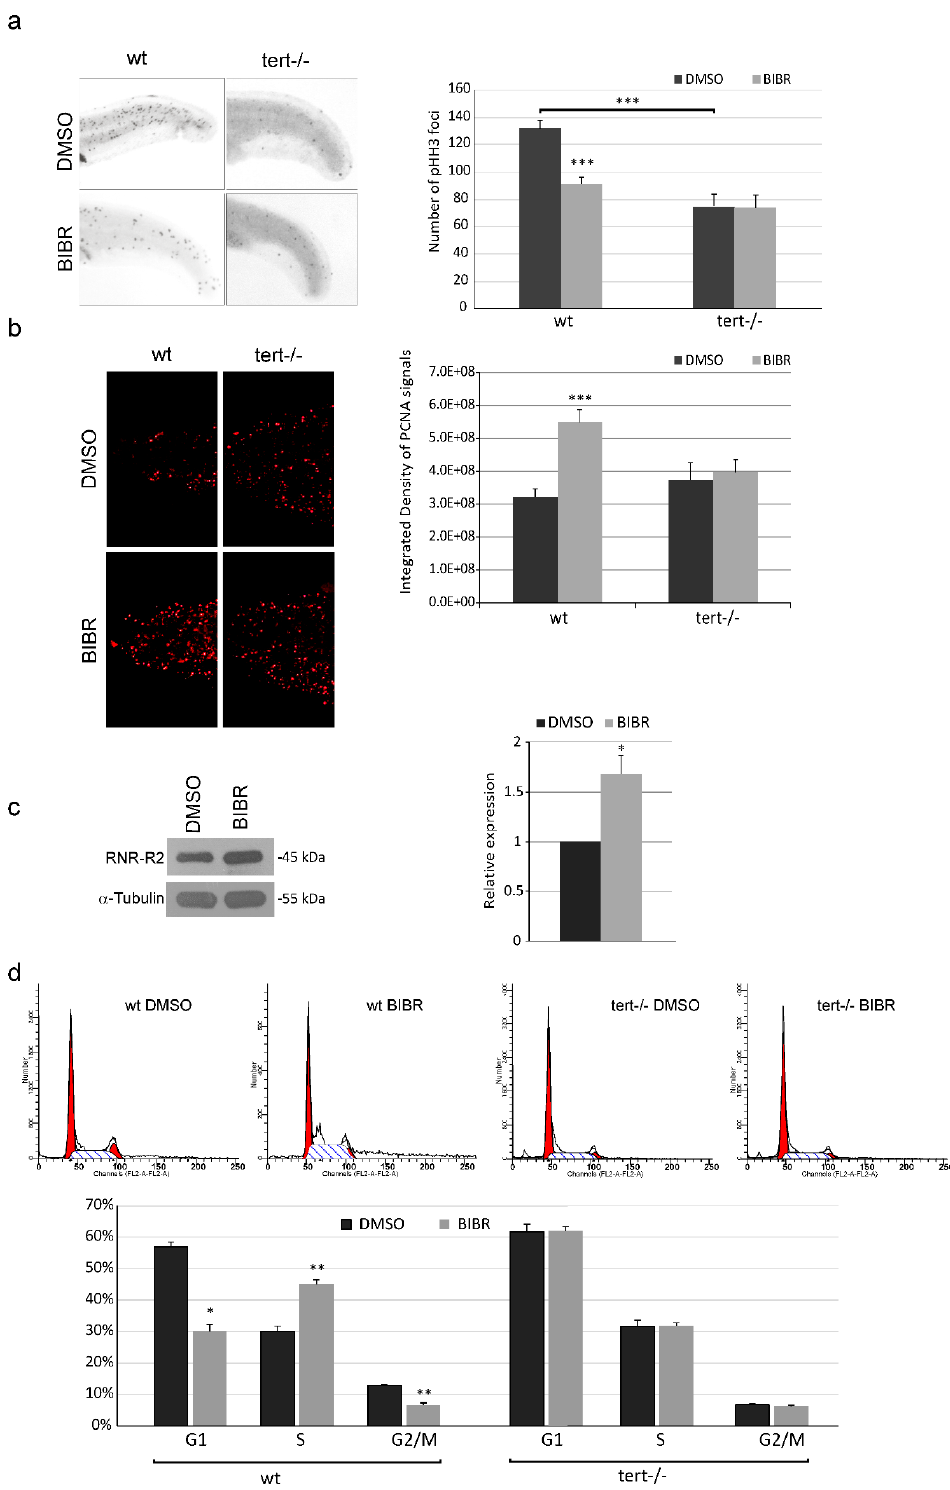
Figure 1. Anti-proliferative effect of short-term telomerase reverse transcriptase (Tert) inhibition by BIBR1532 (BIBR) in zebrafish embryos. ( a ) Representative immunohistochemistry pattern of phosphohistone H3 (pHH3) foci in wt and tert − / − embryos treated with BIBR or DMSO, from 12 to 24 hpf. The graph on the right shows the means and standard deviation (SD) (bar) of pHH3 foci in 20 embryos per group. The quantification analysis of pHH3 foci counted in the caudal portion, from